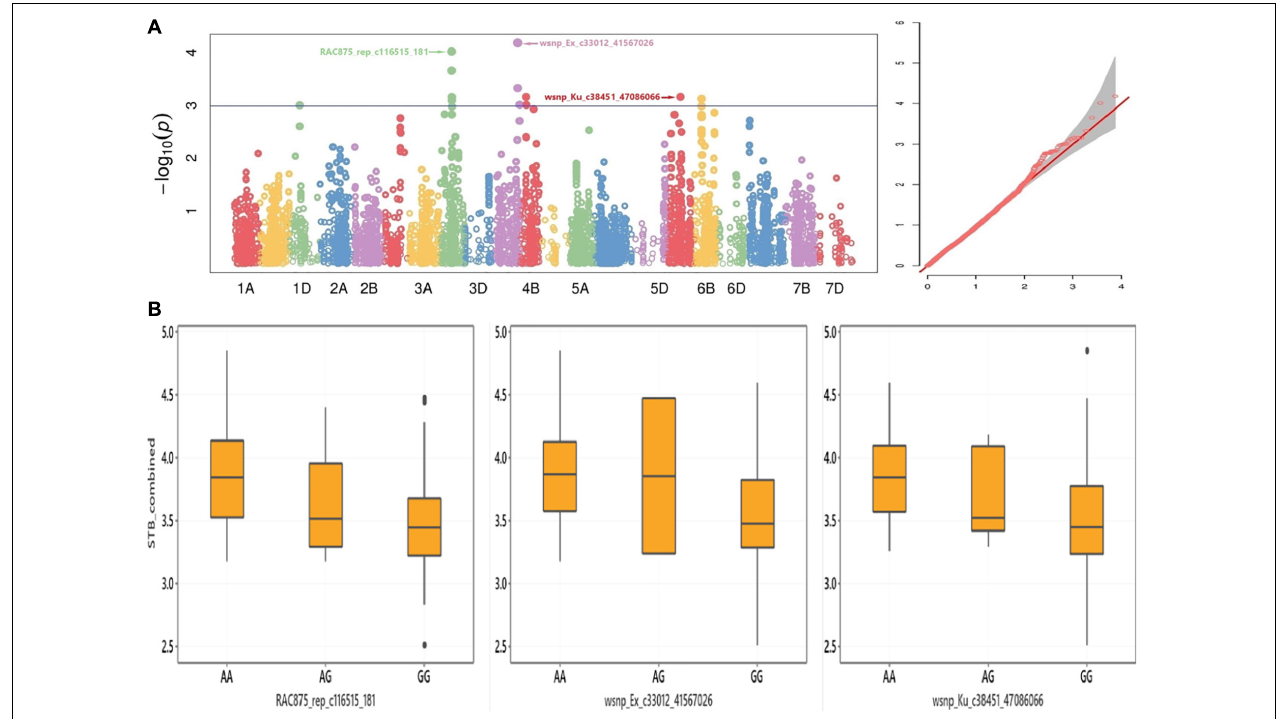
FIGURE 3 | (A) Manhattan (left) and Q–Q (right) plots for GWAS result of adult-plant resistance response to STB and (B) box plots for STB resistance values grouped by alleles of the SNP markers RAC875_rep_c116515_181 , wsnp_Ex_c33012_41567026 , and wsnp_Ku_c38451_47086066 .